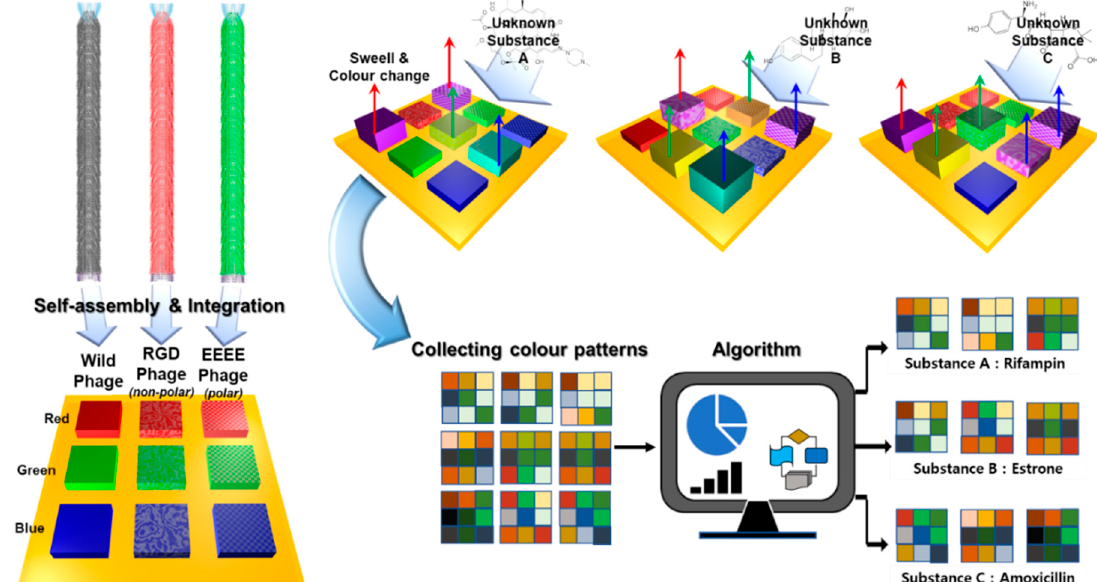
Figure 1. Schematic illustration of the M13 bacteriophage-based colorimetric sensor array. The sensor array consists of a functional M13 bacteriophage with a modified major coat protein (pVIII). When a color band is reacting with a target analyte, each type of sensor chip shows its own color change value according to the individual M13 bacteriophage’s characteristics. A color pattern is formed as a unique response value, and it is possible to construct a sensor platform which can discriminate unknown textures through pattern analysis.